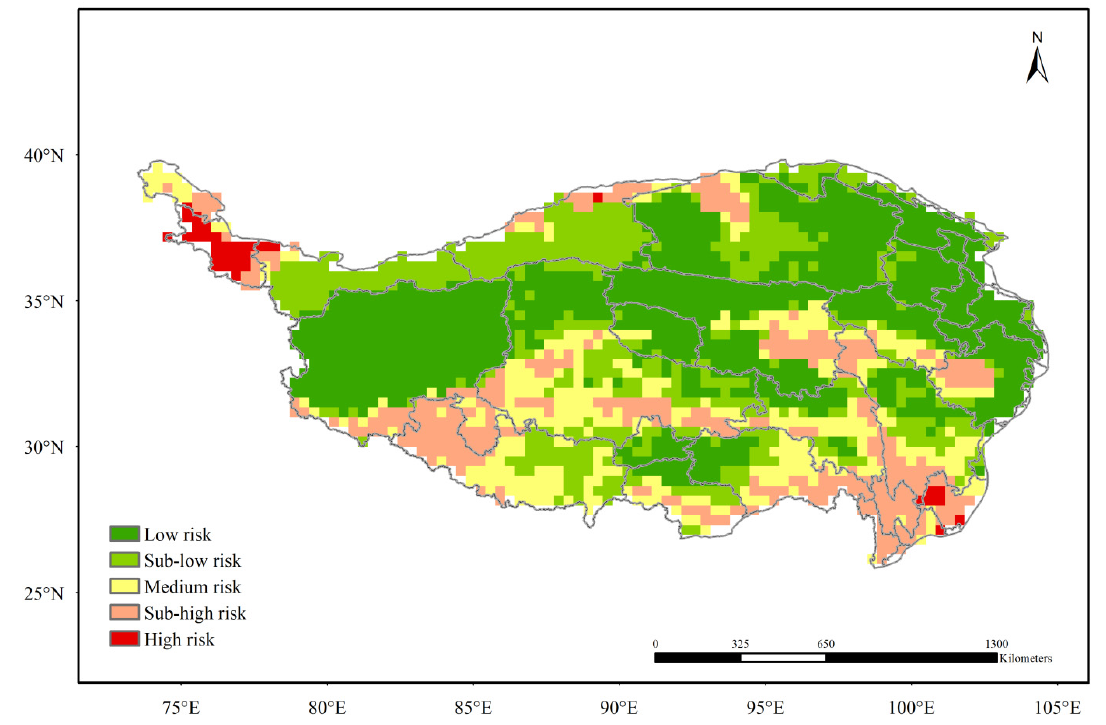
Figure 9. Zoning of the comprehensive risk of snow disasters for husbandry on the